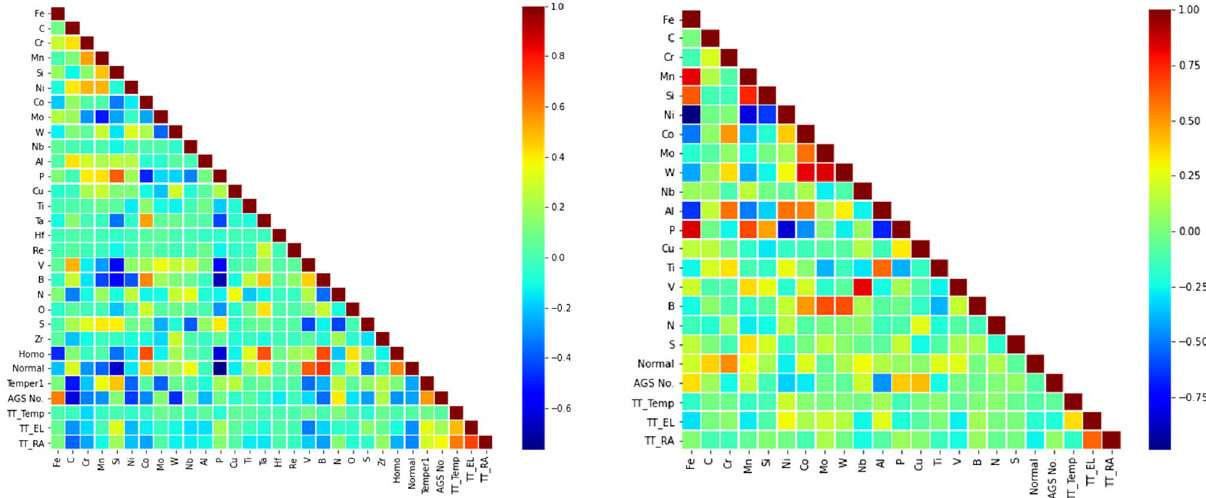
Figure 1. Pearson correlation coefficients of features for the 9–12% Cr FMA (left) and austenitic stainless steel